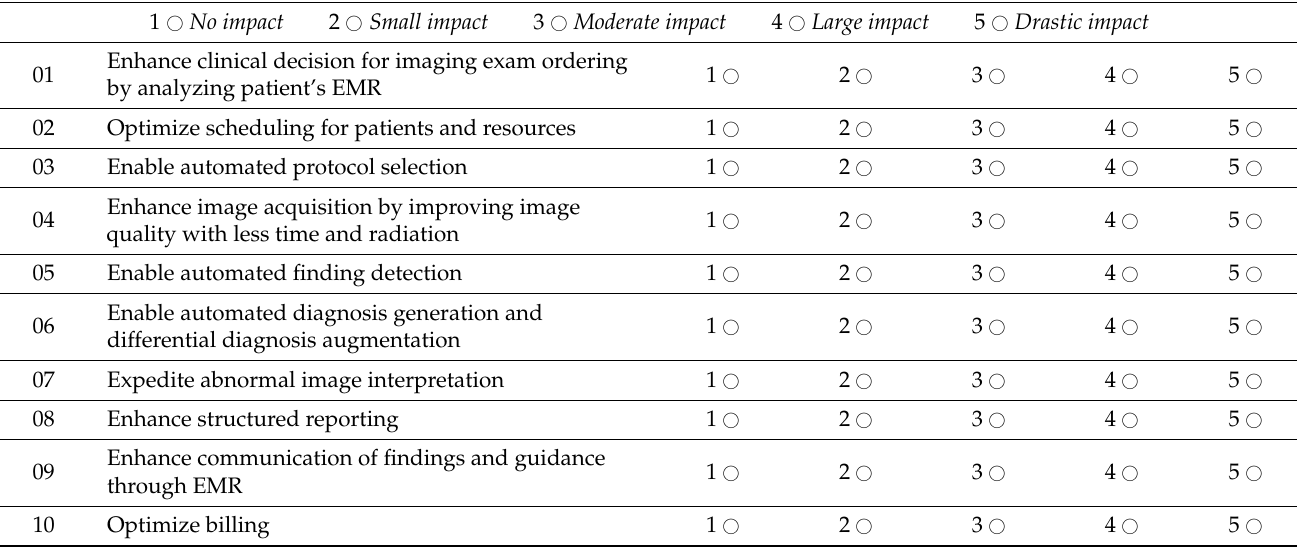
Table A2. Perception of impact of artificial intelligence on radiology